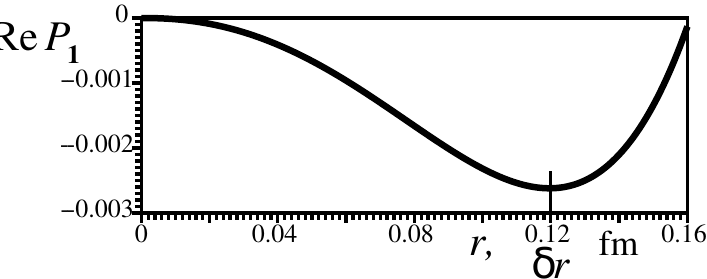
Figure 10. Real part of the pressure P 1 ( r ) in the region of r < 0.16